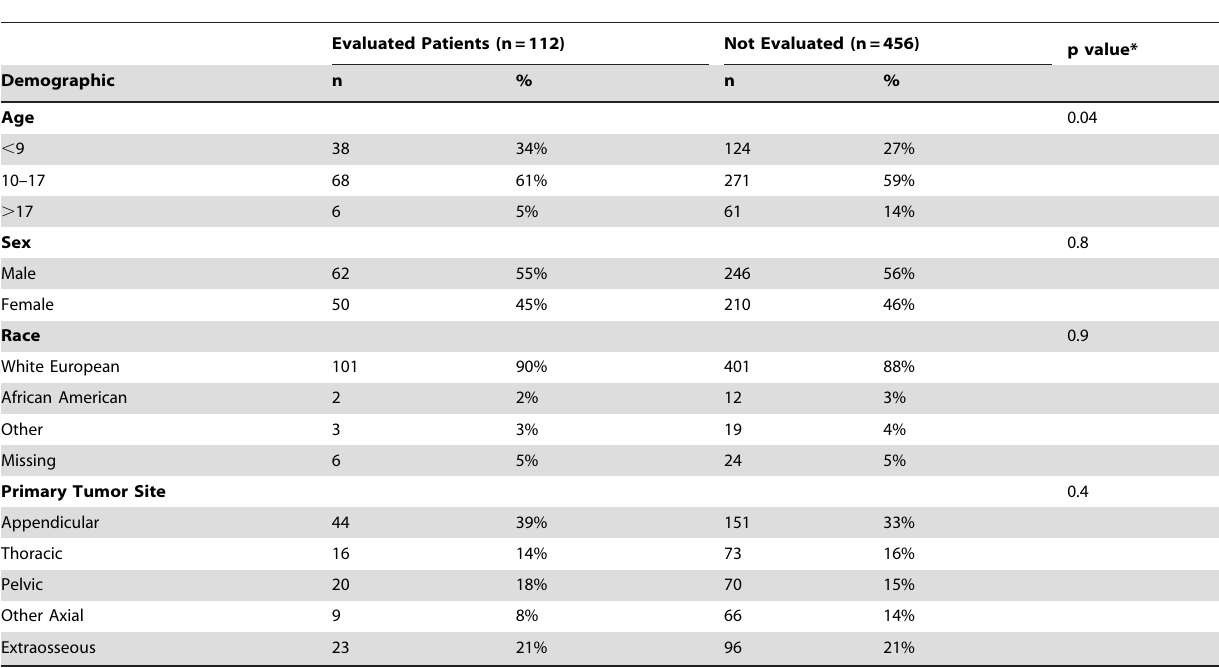
Figure 1. Flow diagram of COG study AEWS0031 patient samples included for GGAA-microsatellite sequencing and clinical analysis. doi:10.1371/journal.pone.0104378.g001 Table 1. Patient demographics of included and excluded AEWS0031